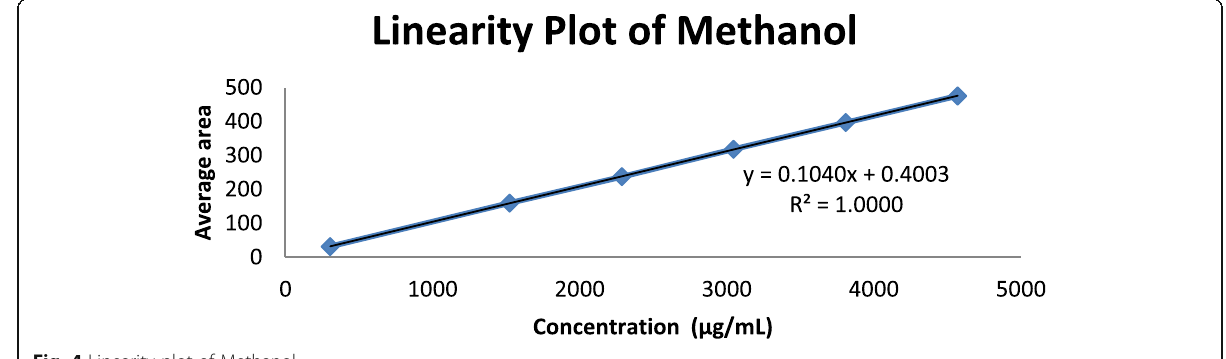
Fig. 4 Linearity plot of